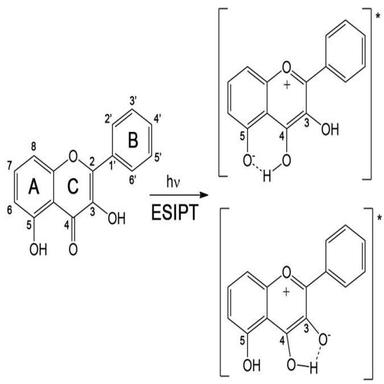
The drastic change in the pKa of the carbonyl and hydroxyl group in C3 and C5, in the excited state, promotes an ultrafast excited proton transfer, which acts as a photoprotective mechanism for these yellow dyes. The 5 hydroxyflavone proton transfer in the excited state involves an intramolecular hydrogen bond six member-ring which is stronger than that in 3 hydroxyflavone possessing a five member-ring, allowing for a more efficient ESIPT.